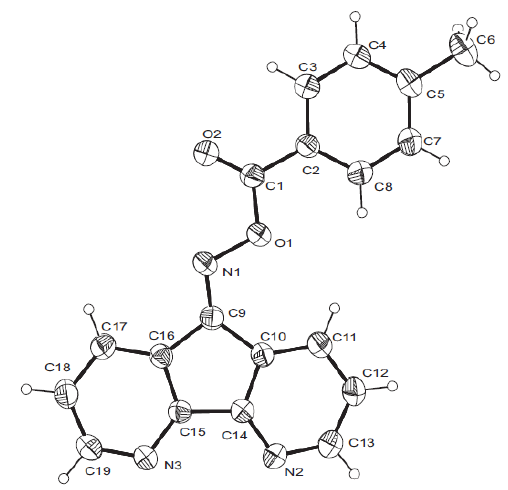
Figure 1. X-ray crystal structure of compound 7b